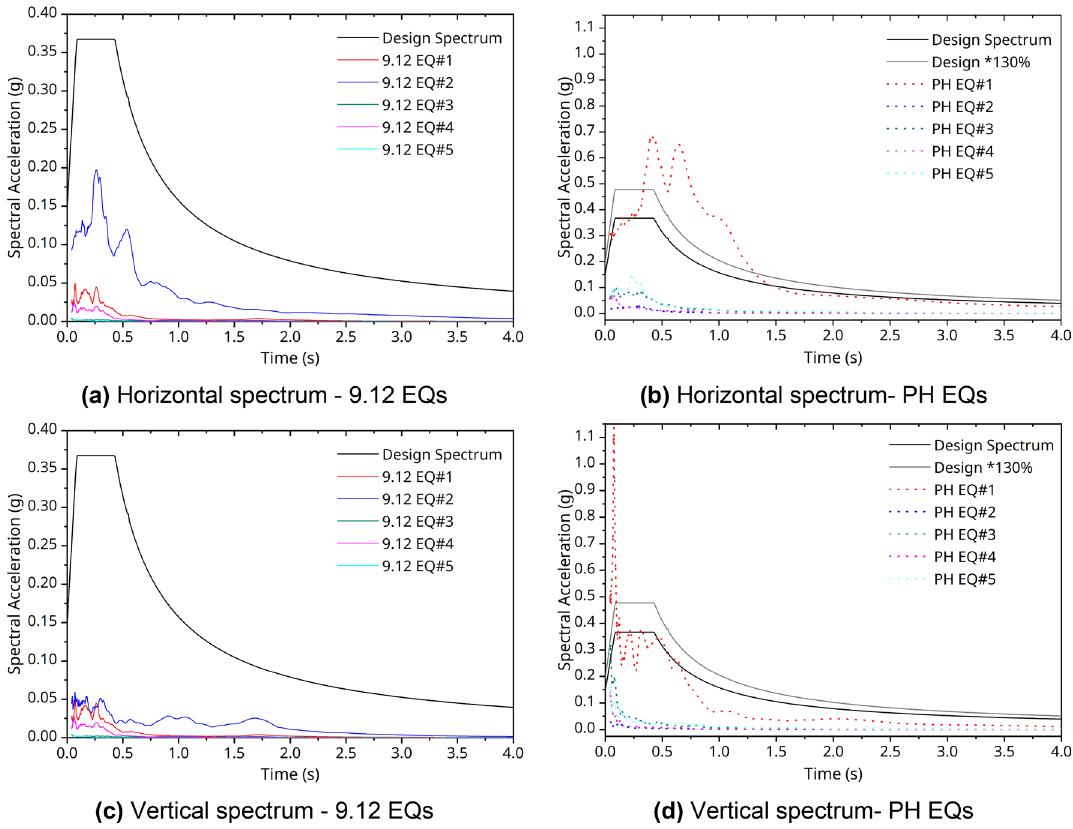
Figure 10. Comparison with the acceleration response spectra and design response spectra.